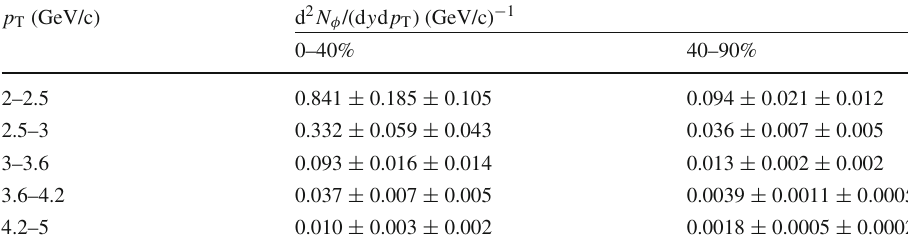
Table 3 φ yield d 2 N /(d y d p T